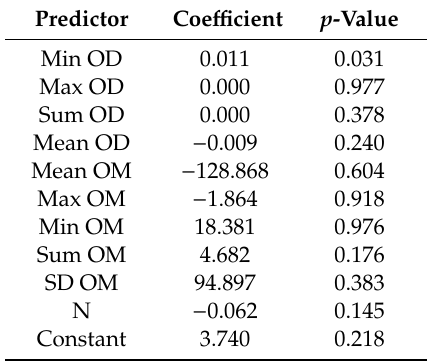
Table 6. Model based on different types of road segments.